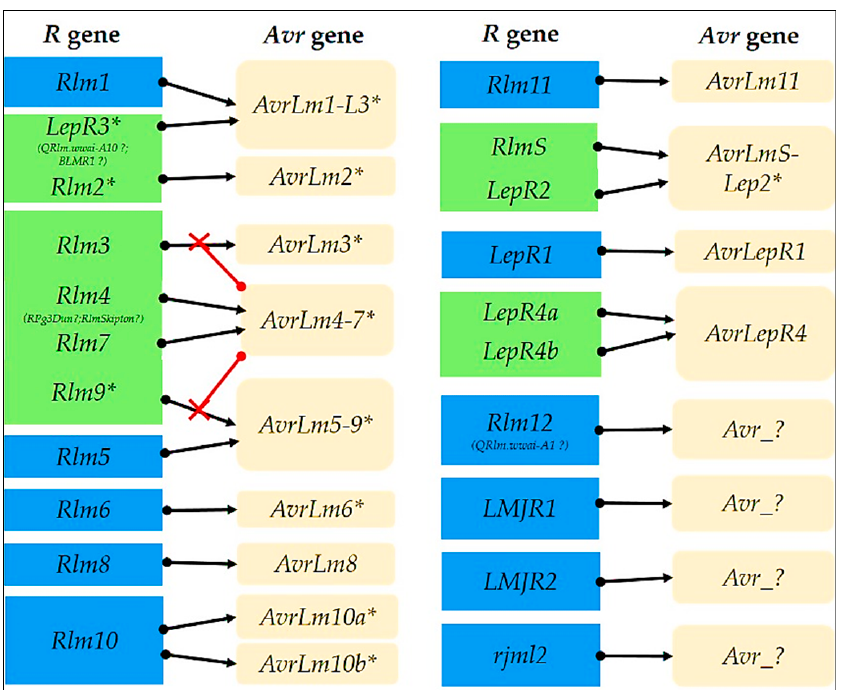
Figure 1. The complex interaction between resistance ( R ) genes and counterpart avirulence ( Avr ) genes mediating blackleg resistance in canola. R genes located in the same block (green) are allelic or suspected to be allelic forms. Avr genes that mask other interactions are indicated by an “x” sign. Genes ( R and Avr ) with an asterisk represent cloned genes. Avr genes with a question mark (?) are hypothetical genes that have not been isolated/discovered to date.